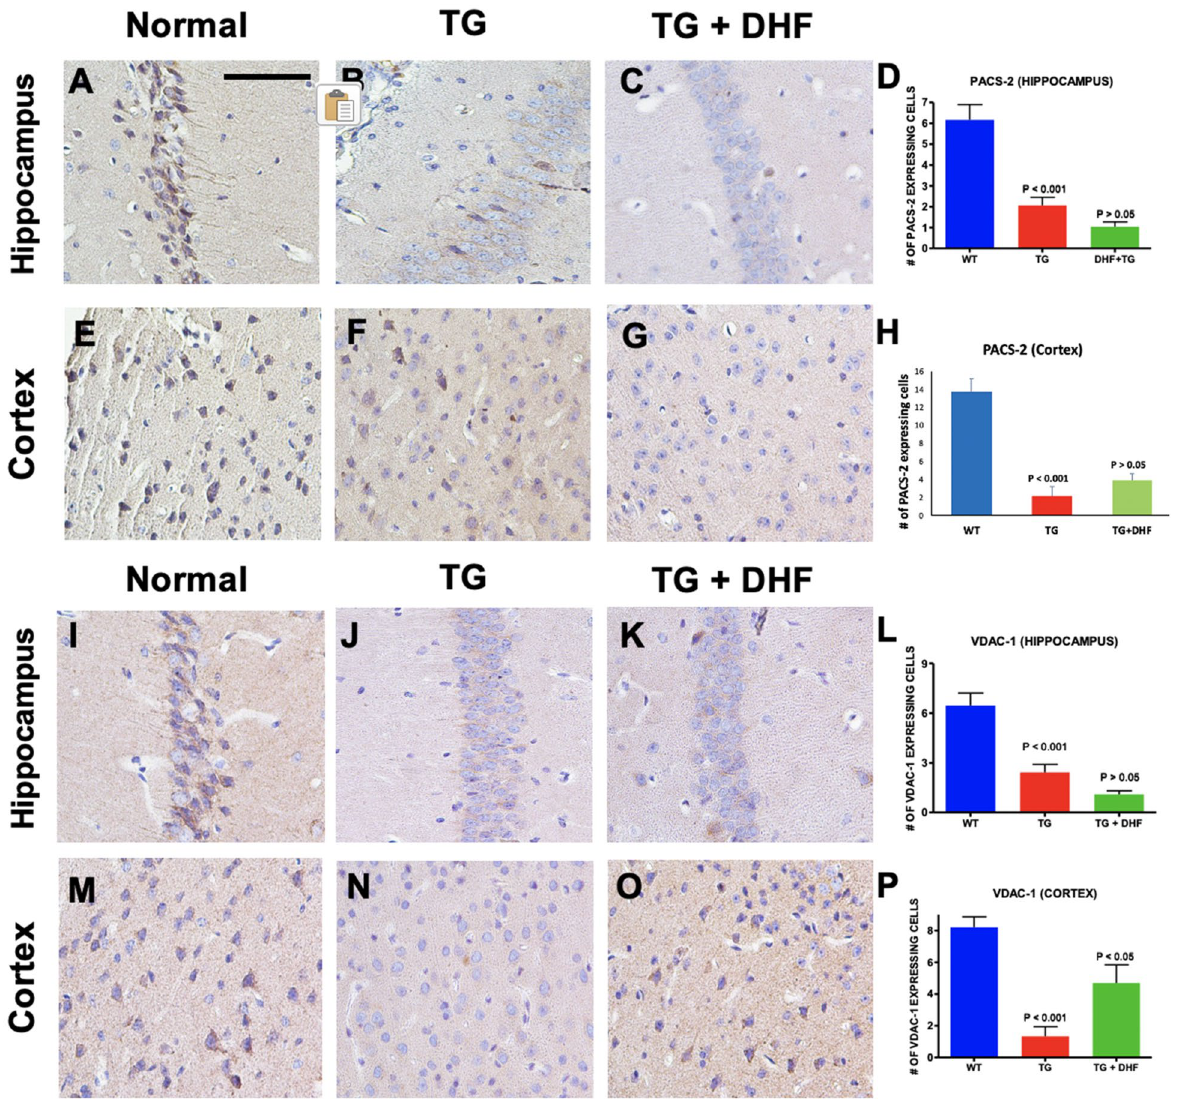
Figure 8. DHF treatment did not improve metabolic function and ER-mitochondria communication. Legend: PACS-2 and VDAC-1 expression in the hippocampus and cortex of Wild Type (WT), Tg26, and DHF treated Tg26 mice ( A - P ). Immunohistochemical stained sections show PACS-2 and VDAC-1 expressing cells in the hippocampal and cortex regions of the mice brains. 3 WT mice, 3 Tg26 mice, and 4 TG + DHF mice were used. A, B, C, E, F, G, I, J, K, M, N, and O are 400 × magnification pictures of the hippocampus and cortex regions of the mice. ( D ) Quantification of PACS-2 expressing cells in the hippocampus: p < 0.001, WT versus Tg; p > 0.05, Tg versus Tg + DHF. ( H ) Quantification of PACS-2 expressing cells in cortex: p < 0.001, WT versus Tg; p > 0.05, Tg versus Tg + DHF. ( L ) Quantification of VDAC-1 expressing cells in the hippocampus: p < 0.001, WT versus Tg; p > 0.05, Tg versus Tg + DHF. ( P ) Quantification of VDAC-1 expressing cells in cortex: p < 0.001, WT versus Tg; p < 0.05, Tg versus Tg + DHF. The total numbers of hippocampal fields analyzed (WT, Tg26, TG + DHF) for each antibody were PACS-2 (62, 110, 112), VDAC-1 (64, 119, 124). The total numbers of cortex fields analyzed (WT, Tg26, TG + DHF) for each antibody were PACS-2 (15, 10, 20), VDAC-1 (15, 15, 20). One Way ANOVA with a Bonferroni’s Multiple Comparison post-test. Scale bar, 100